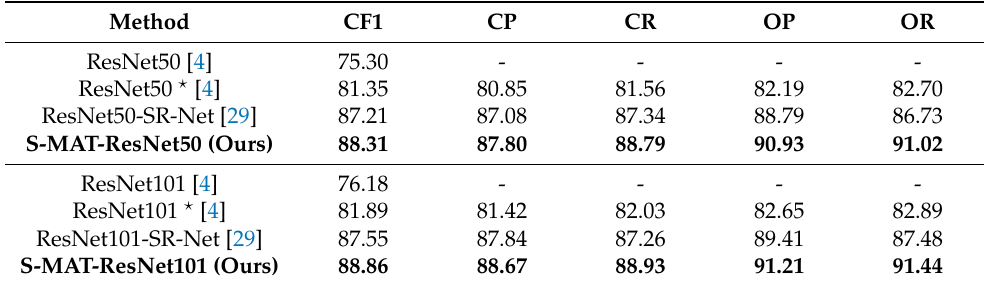
Table 3. Comparisons of our method with previous state-of-the-art methods on the MLRSNet dataset. (cid:63) denotes our implementation. Among all the metrics, CF1 is the primary metric. The bold means the best performance. All metrics are in